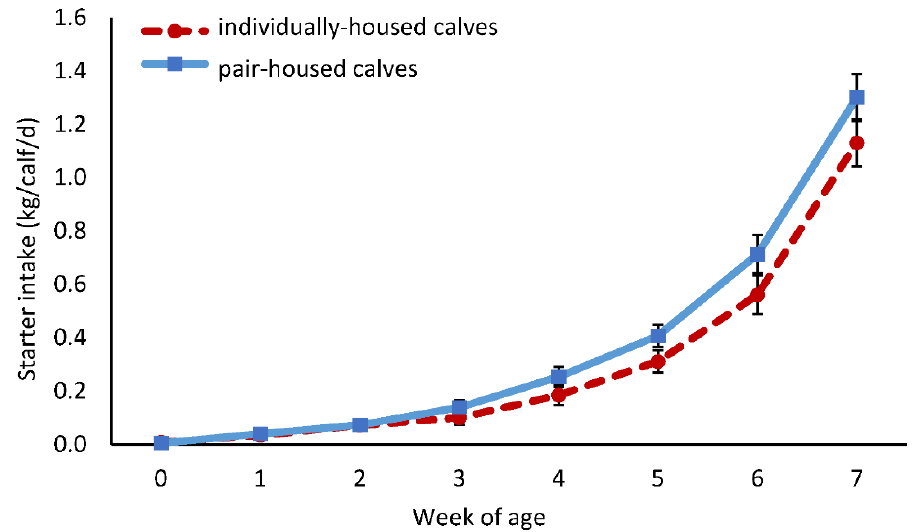
Figure 3. Starter intake (fresh weight) of calves housed individually (IH; n = 20) or in pairs (PH; n = 20 pairs) from birth to week 7 of age. Data were measured at the pen level and summarized by week. Error bars represent